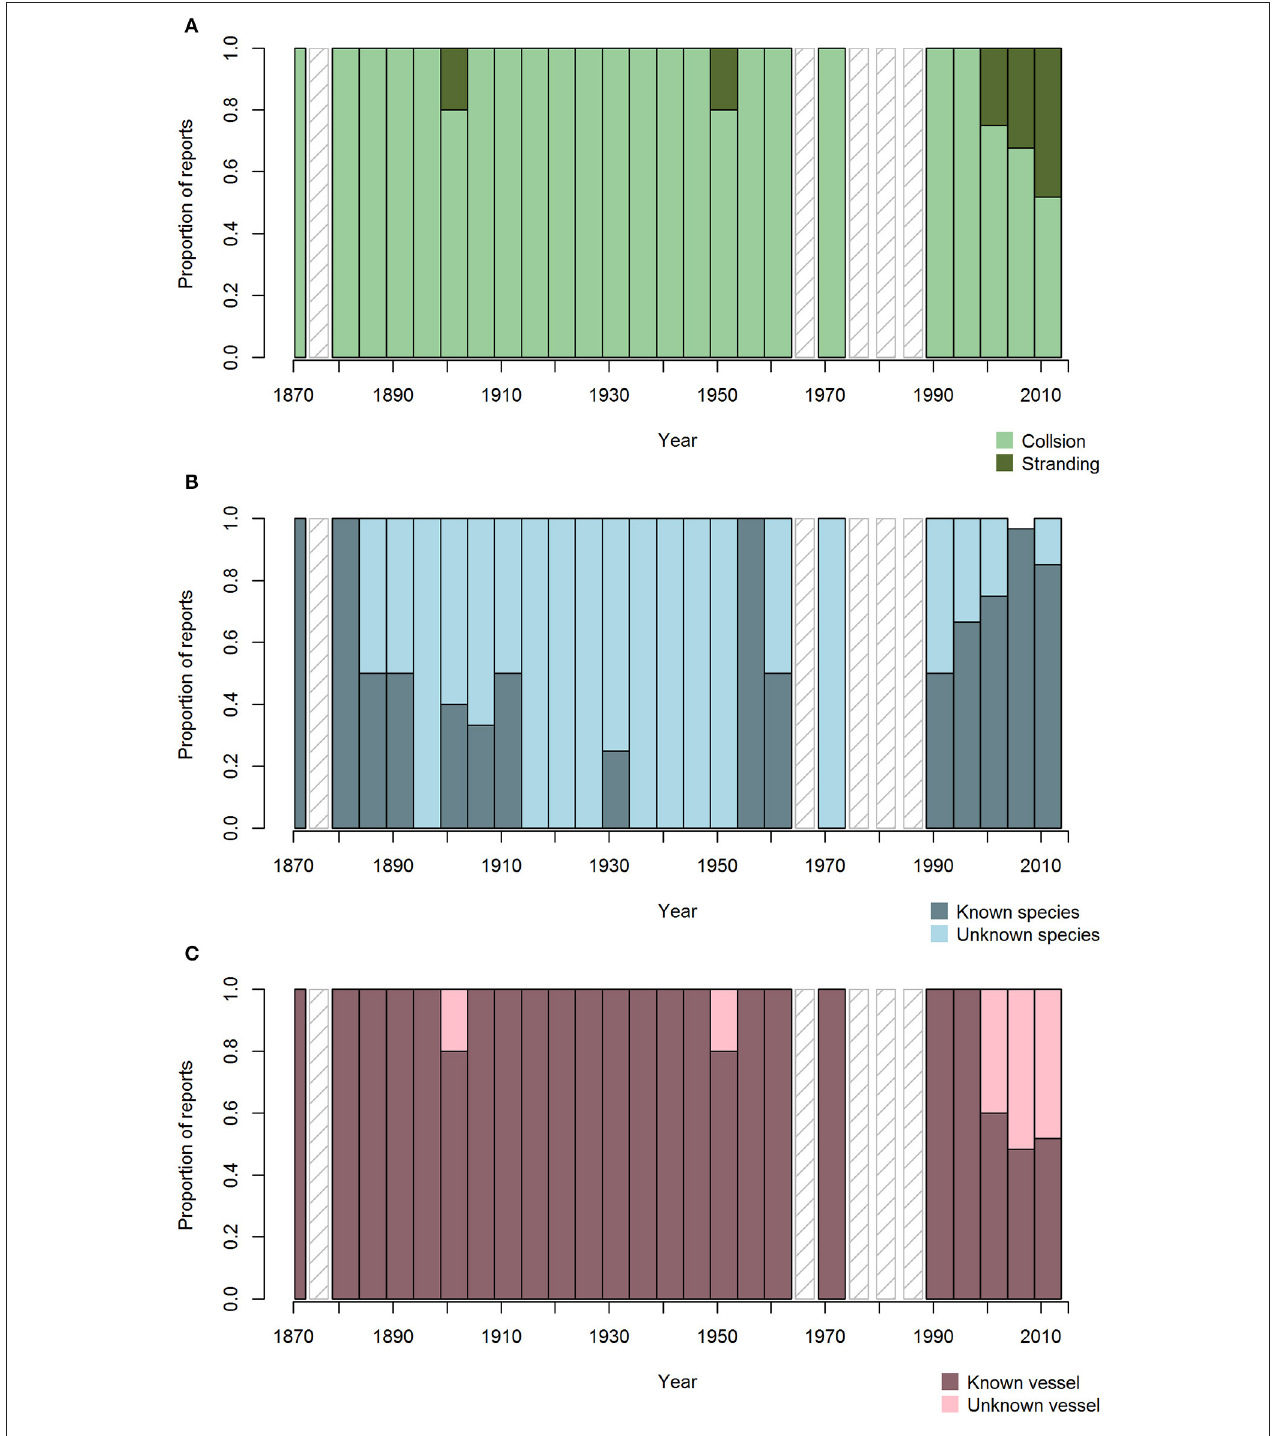
FIGURE 3 | (A) Proportion of Australian reported vessel strikes that came from observed collisions (light green) or discovered bodies (dark green) in each 5-year block, with hatched gray indicating no recorded reports. (B) Proportion of Australian vessel strike reports with known species. Based on 5-year block, with hatched gray indicating no recorded reports. (C) Proportion of Australian vessel strike reports with known